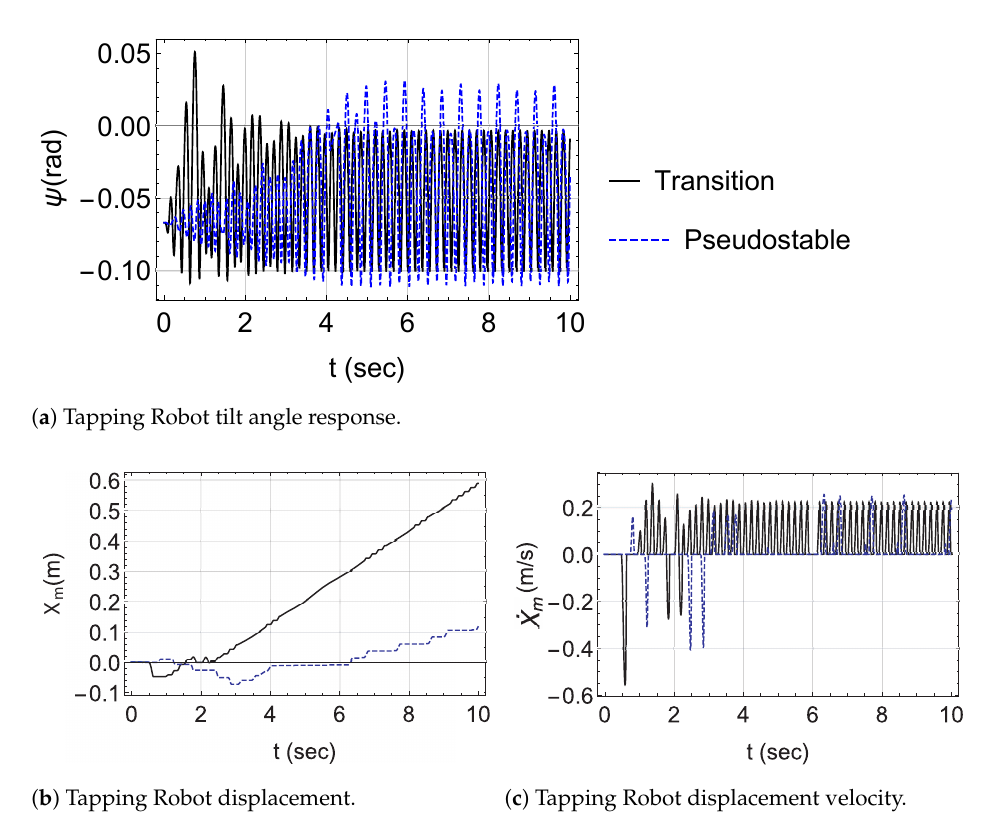
Figure 12. Tapping Robot